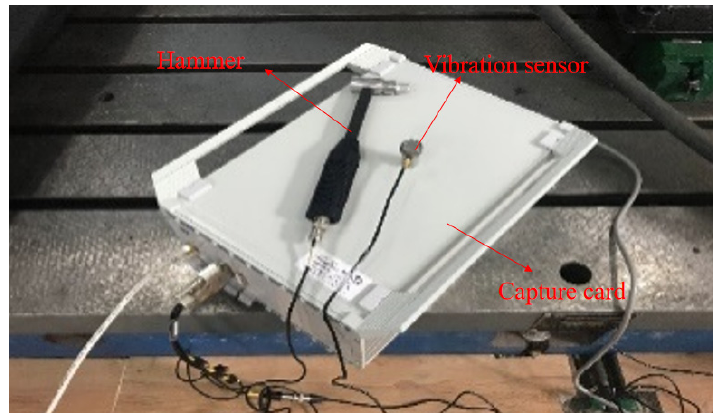
Figure 11. Donghua test acquisition analyzer.